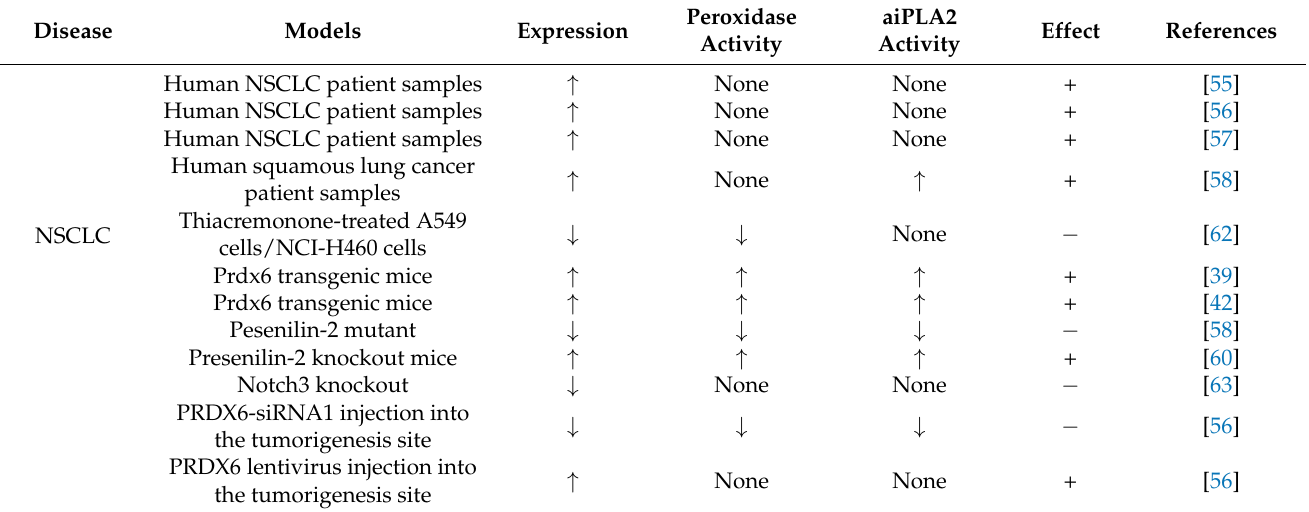
Table 2. PRDX6 expression and activity changes in NSCLC